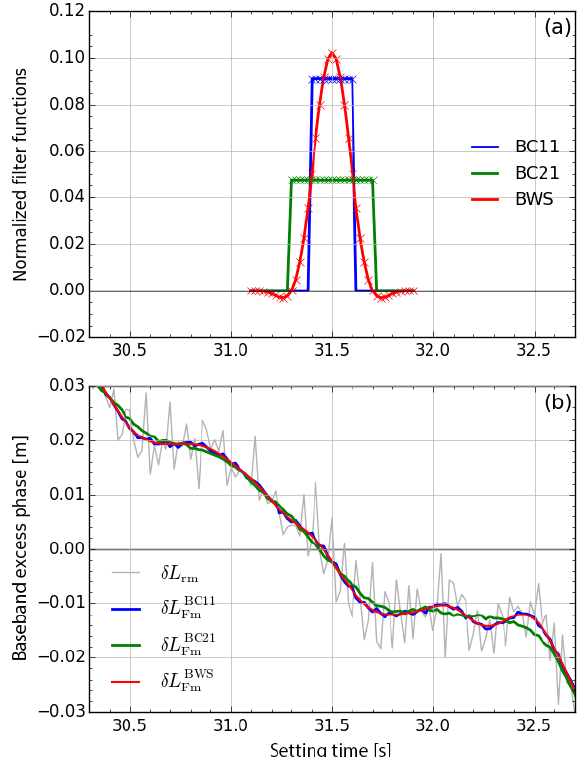
Figure A1. Comparison of the Blackman windowed sinc (BWS) low-pass filter and boxcar (BC) filters based on a representative segment (between 30.3 and 32 . 7s) of the excess phase profile L r1 of the COSMIC example event. (a) Filter functions for the BWS filter with f c = 2 . 5Hz and M = 41 points (“BWS”, red) and box- car filters with M = 21 points (“BC21”, green) and with M = 11 points (“BC11”, blue), around the central value of the segment (31 . 5s). (b) Filter effects on the excess phase profile L r1 from running the filters over the segment. Shown are the unfiltered ex- cess phase delta profile (“ δL rm ”, light gray), the BWS filtered pro- file with f c = 2 . 5Hz and M = 41 points (“ δL BWS ”, red), and the Fm boxcar filtered profiles with M = 21 points (“ δL BC21 ”, green) and Fm M = 11 points (“ δL BC11 ”, Fm